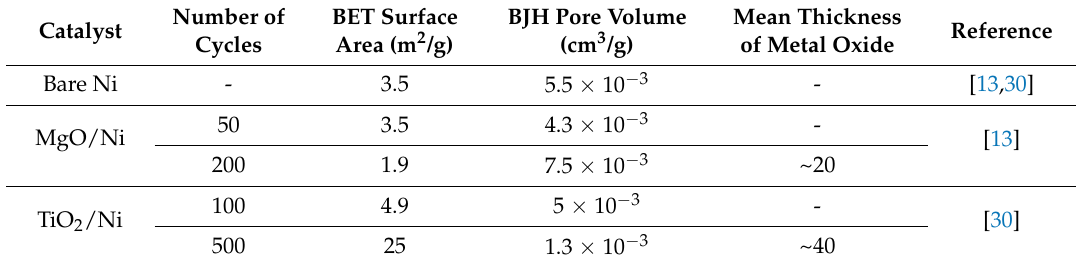
Table 1. Brunauer-Emmett-Teller (BET) surface area and Barret-Joyner-Halenda (BJH) pore volume of bare Ni, MgO/Ni (50 and 200 ALD cycles), and TiO 2 /Ni (100 and 500 ALD cycles). The ALD-deposited metal oxide thicknesses of MgO/Ni (200 cycles) and TiO 2 /Ni (500 cycles) determined by TEM analysis are also